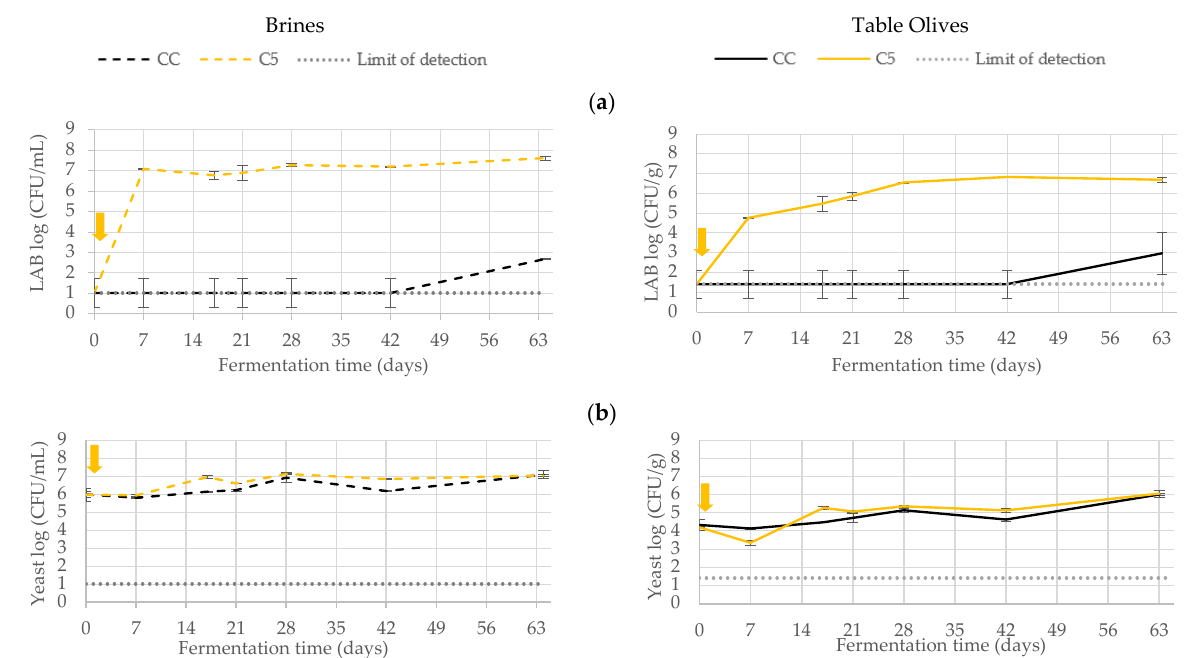
Figure 4. Evolution of viable numbers of ( a ) lactic acid bacteria and ( b ) yeasts, in ( left ) brines and ( right ) table olives, under plan C. Arrows indicate the moment of inoculation with Lpb. pentosus i106 and the corresponding salt addition to all vessels.